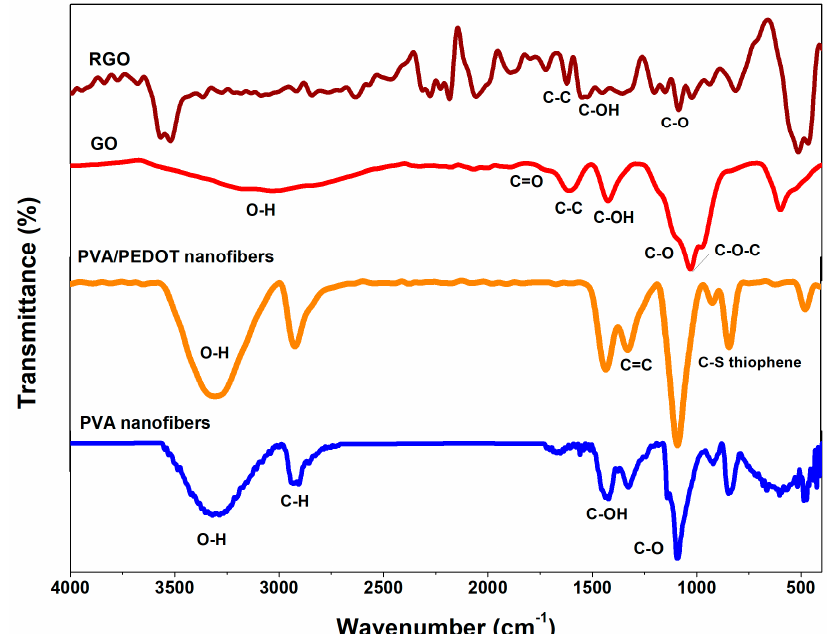
Figure 3. Fourier transform infrared spectroscopy (FTIR) spectra of PVA nanofibers, PVA/PEDOT nanofibers, graphene oxide (GO), and rGO.